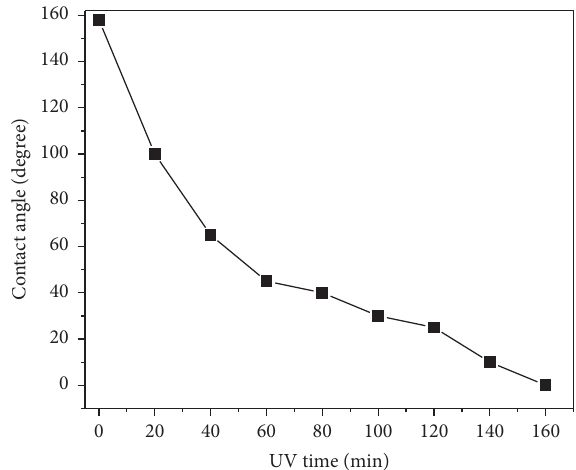
Figure 6: Contact angle versus UV irradiation time for the water droplet on the surface of ZnO nanorod